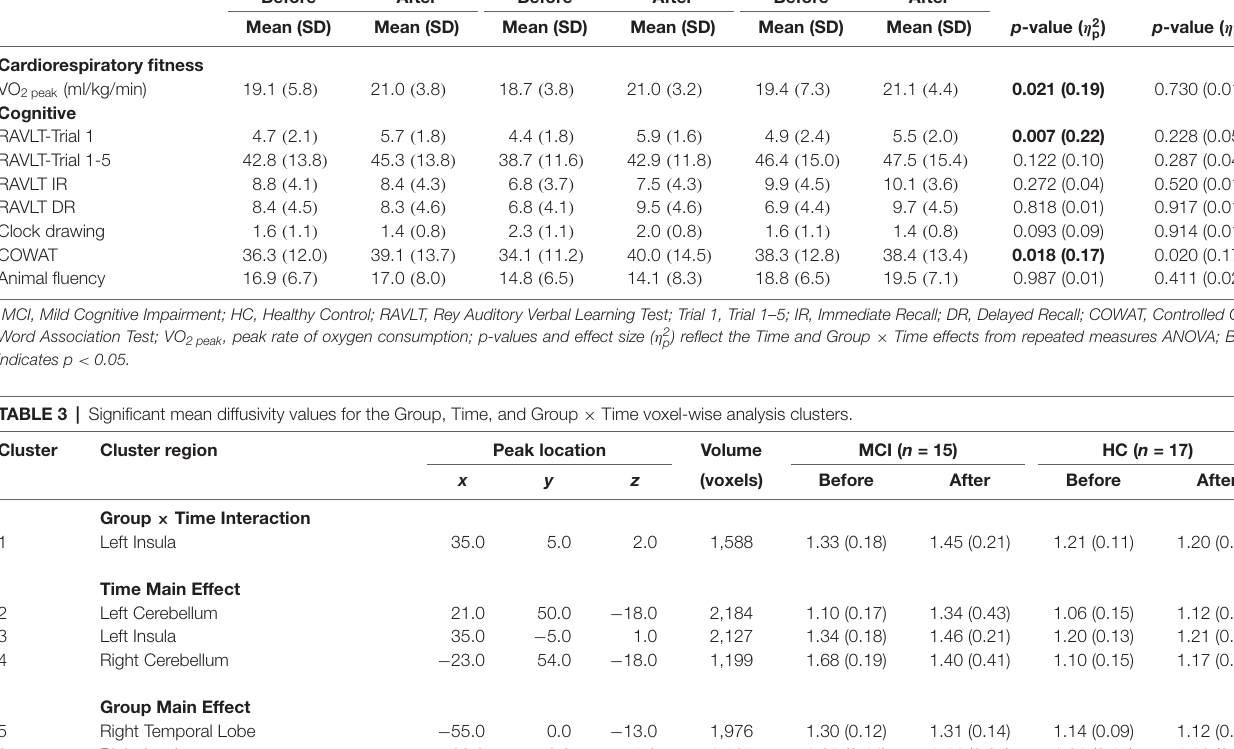
TABLE 2 | Cardiorespiratory fitness and neuropsychological performance data. Total sample ( n = 32) MCI ( n = 15) HC ( n = 17) Time Group × Time Before After Before After Before After Mean (SD) Mean (SD) Mean (SD) Mean (SD) Mean (SD) Mean (SD) p -value ( η 2 p ) p -value ( η 2 p ) Cardiorespiratory fitness VO 2peak (ml/kg/min)